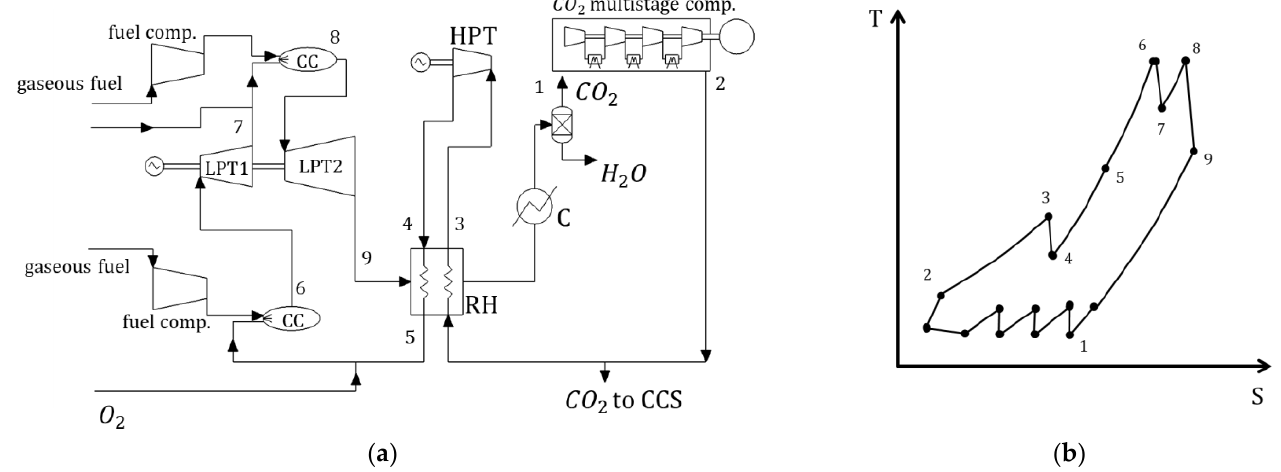
Figure 18. MATIANT cycle: ( a ) schematic diagram; ( b ) T – S diagram [32]. Comp. — compressor; CC — combustion chamber; LPT — low-pressure turbine; RH — regenerative heat exchanger; HPT — CC—combustion chamber; LPT—low-pressure turbine; RH—regenerative heat exchanger; high-pressure turbine; C — cooler. HPT—high-pressure turbine;